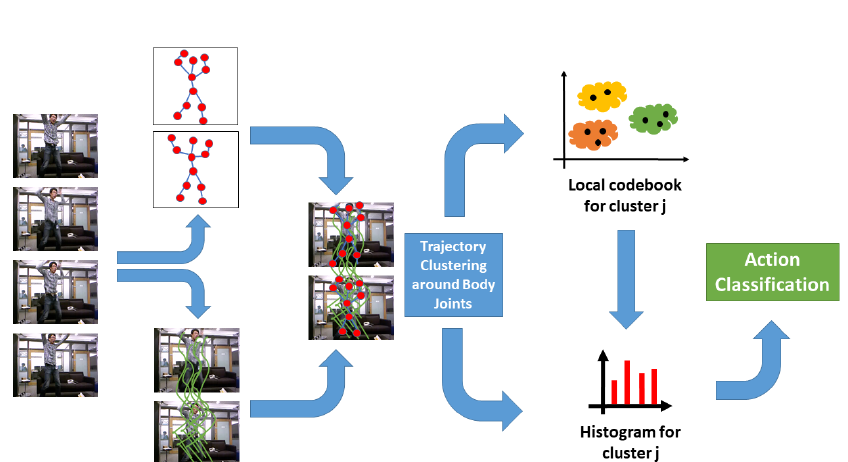
Figure 1. Proposed 2D Localized Trajectories approach. From an RGB sequence, Dense Trajectories are